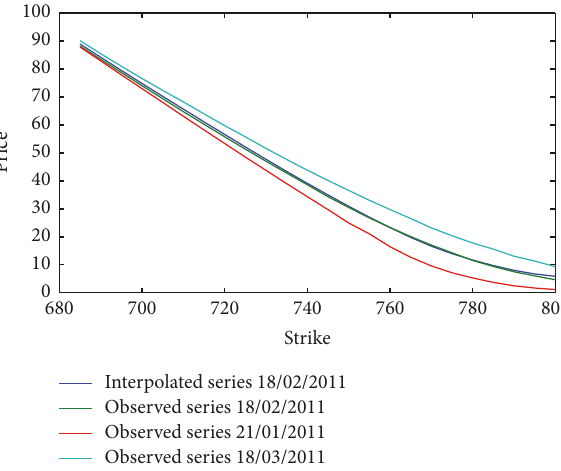
Figure 4: The figure calls interpolated and observed Series on 04/01/2011 (maturity 18/02/2011).